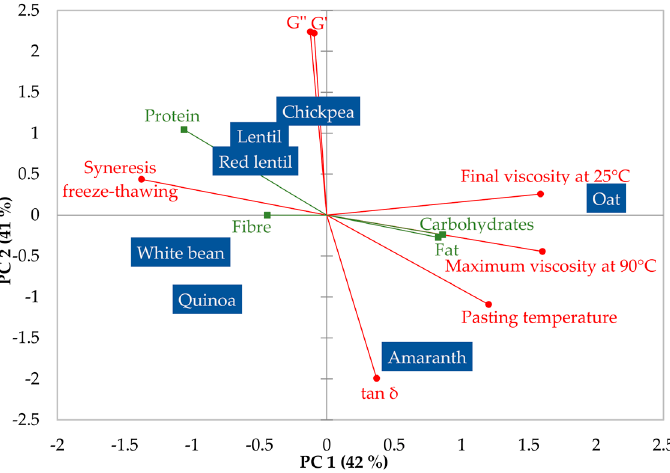
Figure 5. PCA plot showing the variation in the thermal properties of fl ours from di ff erent vegetable sources. Proximate composition variables were included as supplementary variables. sources. Proximate composition variables were included as supplementary